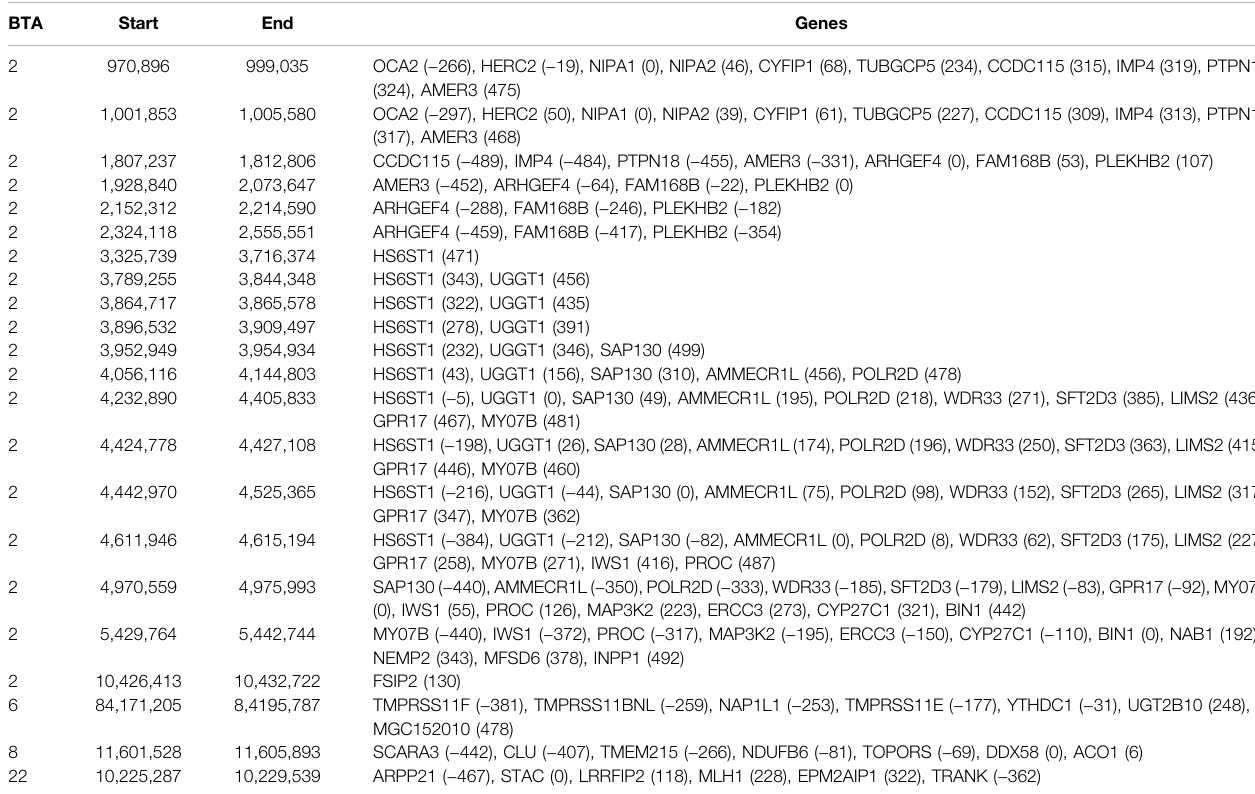
TABLE4| Chromosome(BTA)andstartandendposition(bp)ofeachimprintedQTLregionsde fi nedforcarcassconformation,aswellasthenameofgeneslocatedwithina 0.5 Mb window of each region [distance (in Kb) from the lead SNP of each region in parenthesis] a . BTA Start